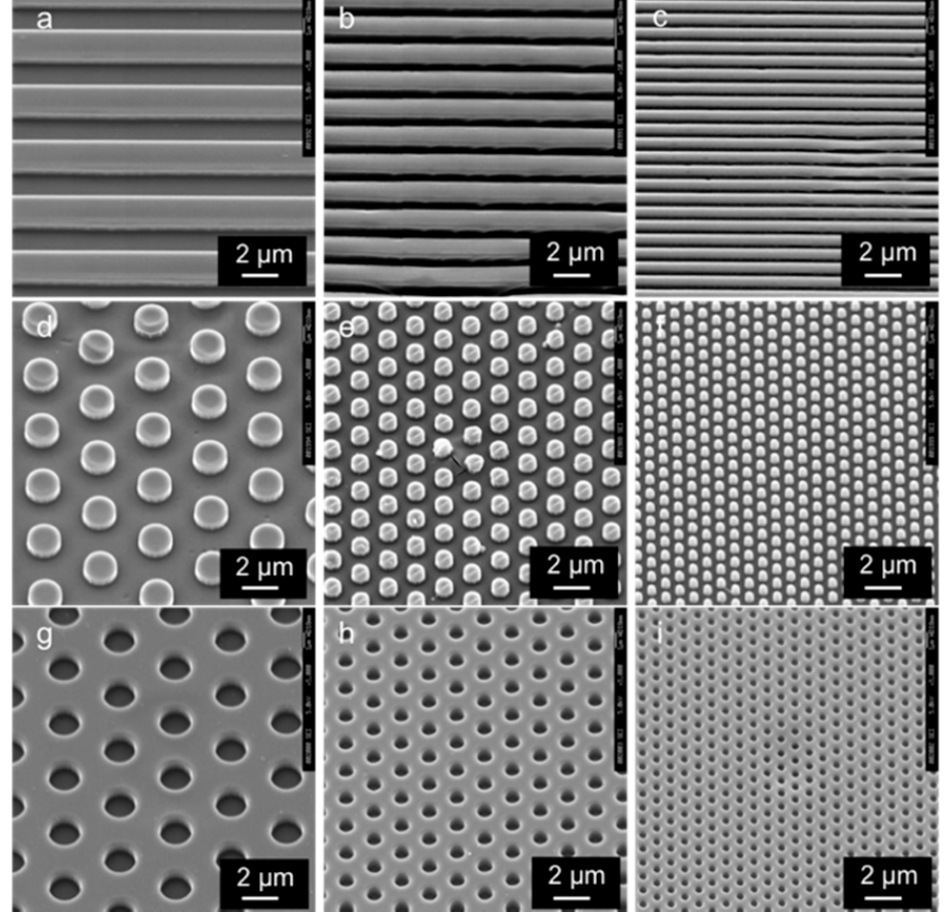
Figure 2. SEM images of the patterned PLGA membranes. Groove widths of ( a ) 2.0, ( b ) 1.0, and ( c ) 0.5 µ m; pillared widths of ( d ) 2.0, ( e ) 1.0, and ( f ) 0.5 µ m; and hole widths of ( g ) 2.0, ( h ) 1.0, and ( i ) 0.5 µ m. Scale bar = 2.0 µ m. Figure 3 and Table 1 show the laser microscope images and pattern sizes of the micro/nano-structured PLGA membranes. The groove widths were 2.0 ± 0.01, 1.0 ± 0.01, and 0.5 ± 0.02 µ m. The pillar widths were 2.0 ± 0.01, 1.0 ± 0.03, and 0.5 ± 0.04 µ m. The hole widths were 2.0 ± 0.03, 1.0 ± 0.04, and 0.5 ± 0.05 µ m. The height or depth of each pattern was approximately 1.0 µ